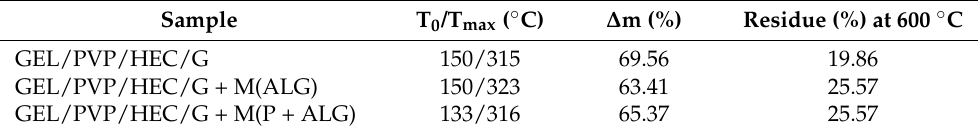
Table 4. The temperature of the beginning of the sample decomposition (T 0 ), the temperature at the maximal rate of the process (T max ), the weight loss in the main stage ( Δ m), and the char residue at 600 °C for the prepared materials.